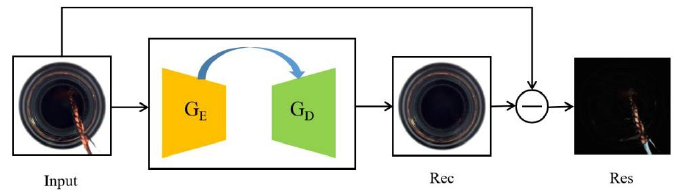
Figure 7. The algorithm frame diagram of the encode – decode with a skip-connection.